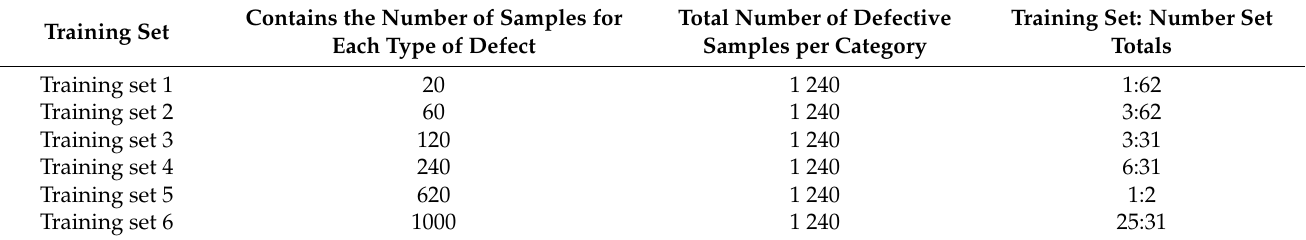
Table 4. Setting of each training sample size in the experiment’s target domain.